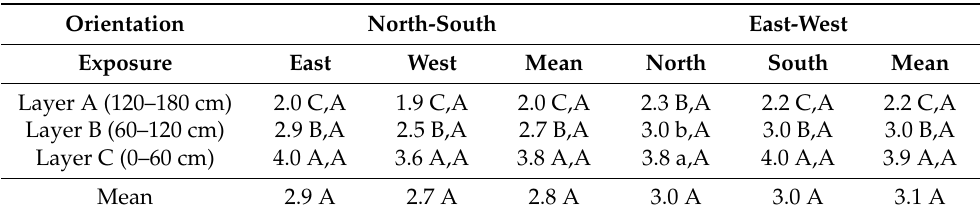
Table 5. Mean LAI (m 2 m − 2 ) at DOY 180. The first letters denote significant differences between layers for a given exposure; the second letters denote significant differences between exposures for a given layer (SNK test). Lower case letters denote statistical differences with p = 0.05. Capital letters denote statistical differences with p =